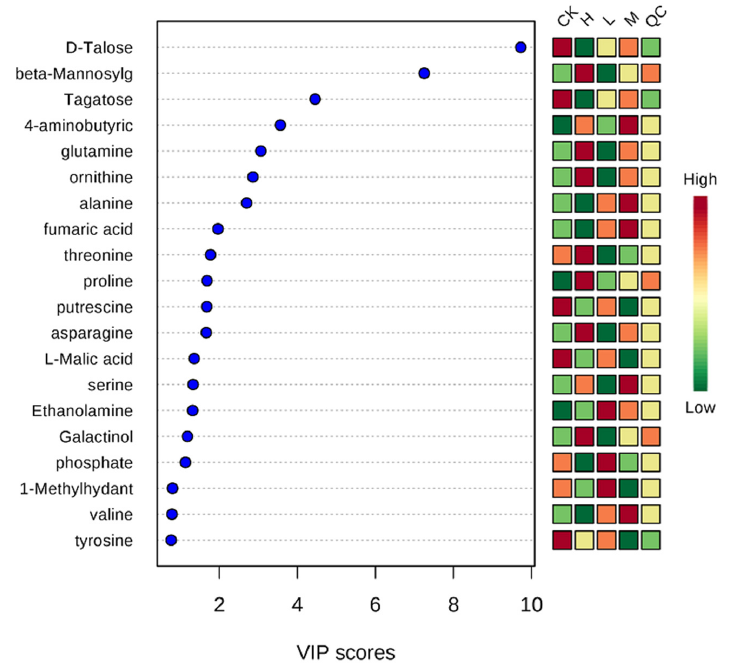
Figure 5. Variable importance in projection (VIP) scores from partial least-squares